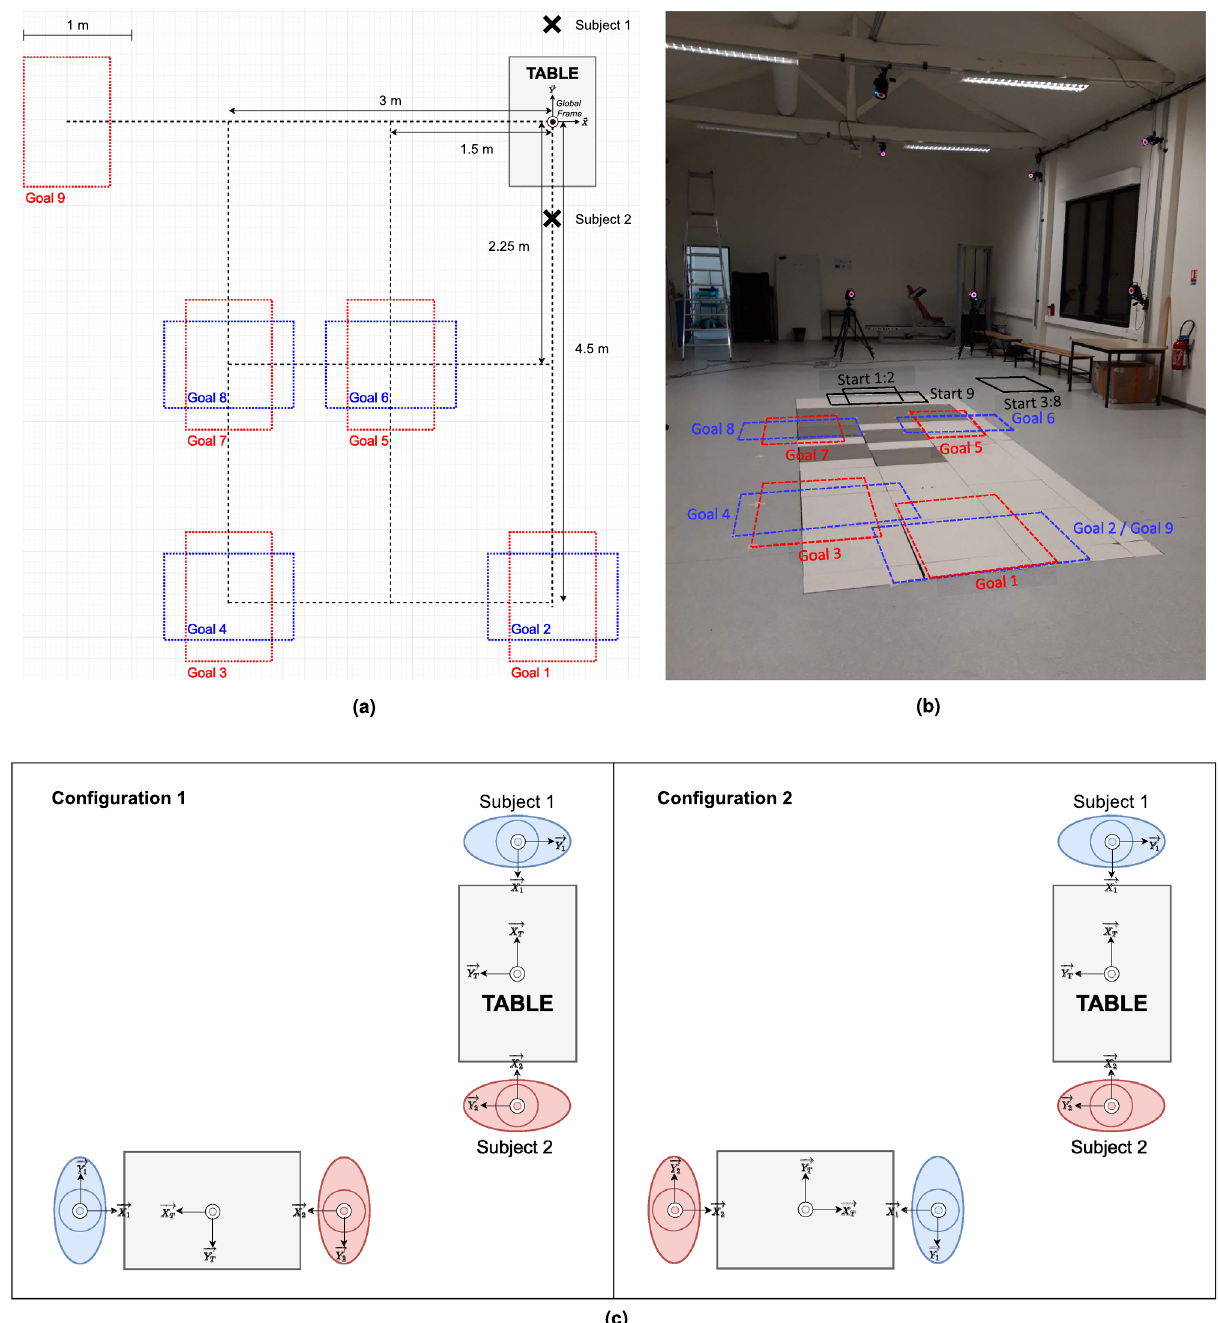
Figure 1. Experimental setup. ( a ) Representation of the 9 different goal positions. ( b ) Experiment room. The goal positions correspond to the ones represented in ( a ). ( c ) Two achievable configurations when handling